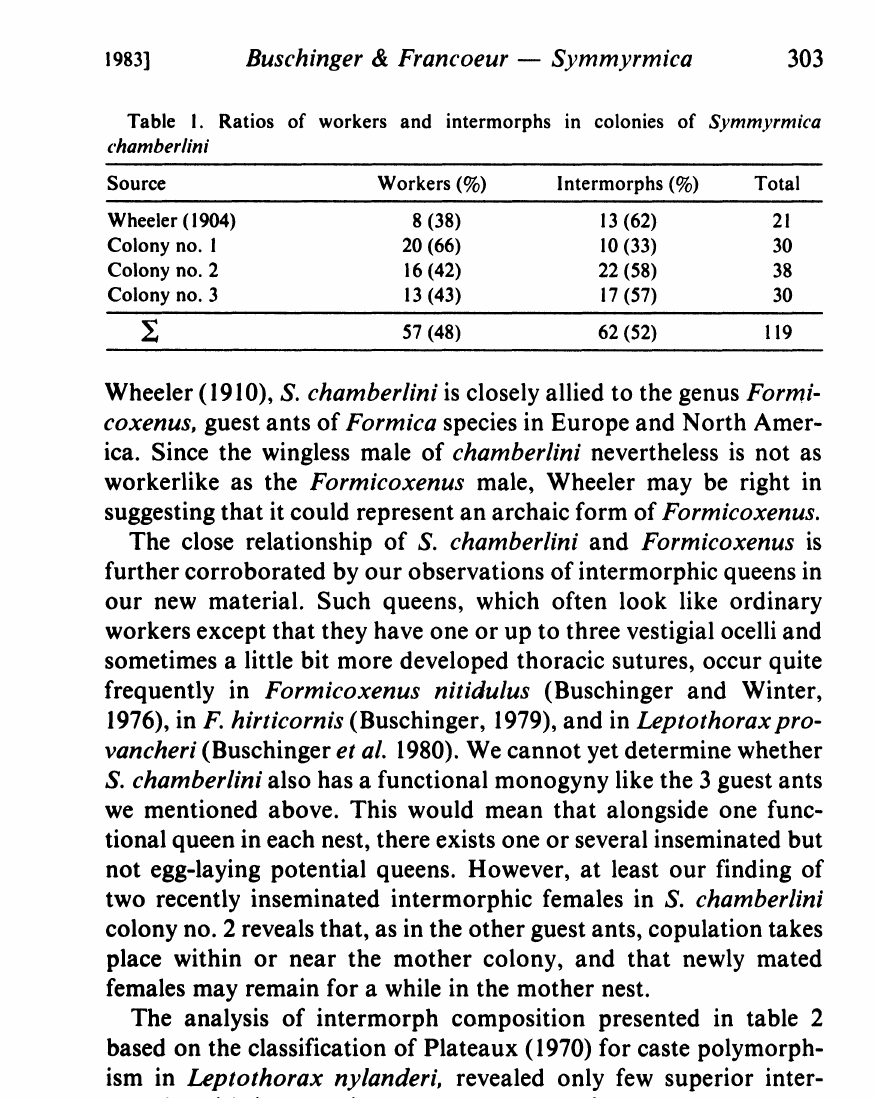
Table I. Ratios of workers and intermorphs in colonies of Symmyrmica chamberlini Source Workers